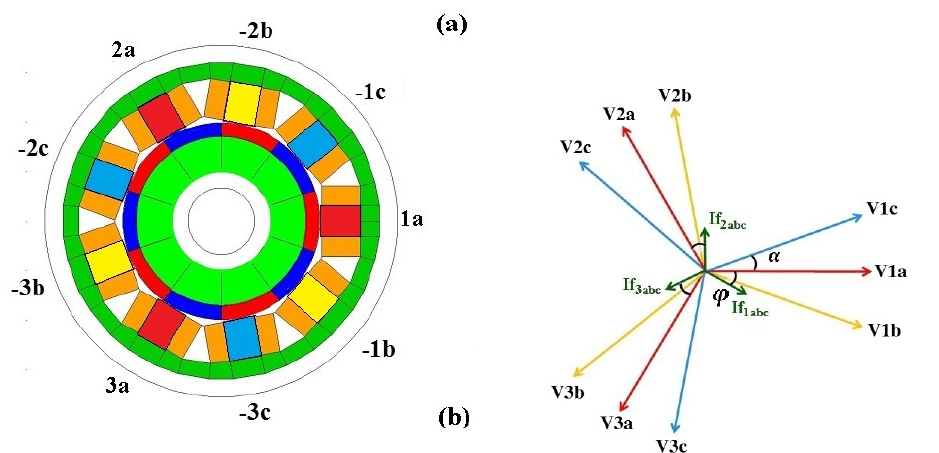
Figure 2. Case II : base machine ( a ) and phasor diagrams ( b ). Red stator teeth are supplied by the converter a , yellow teeth by the converter b ; blue teeth by the converter c . ϕ is the V-I phase angle and α is the electric angle between coil supplied by different